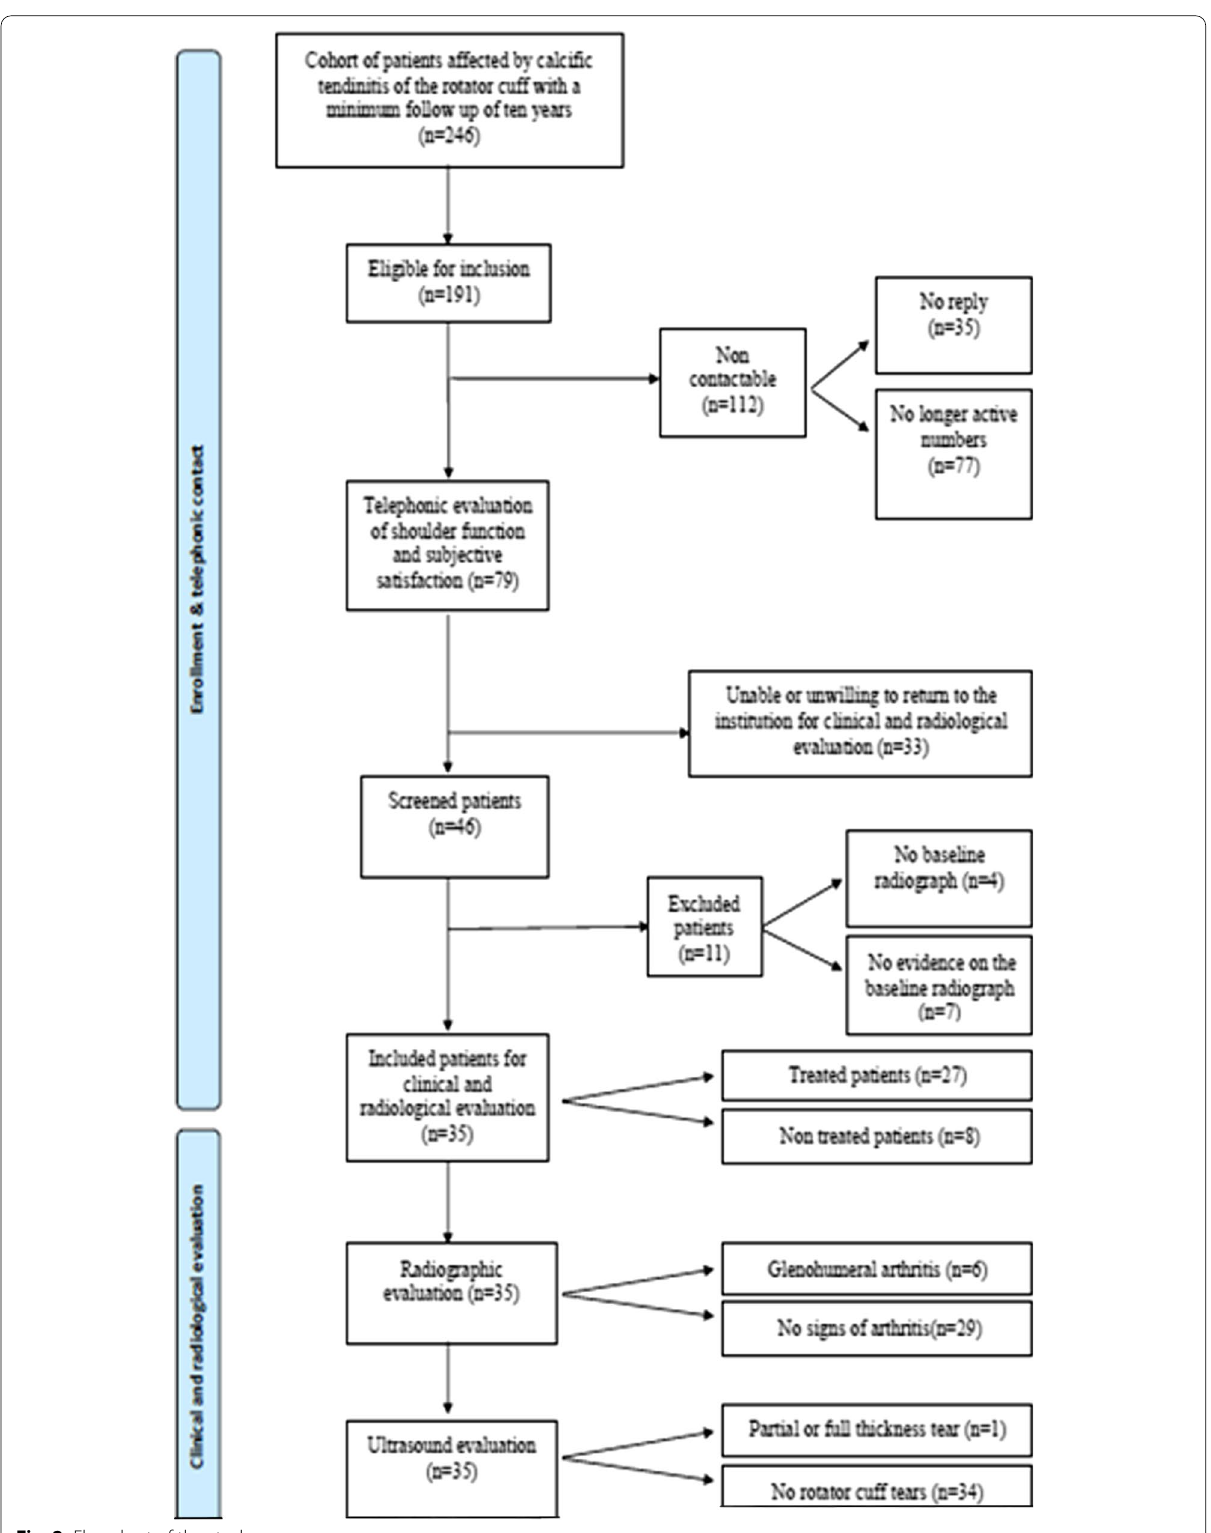
Fig. 2 Flowchart of the